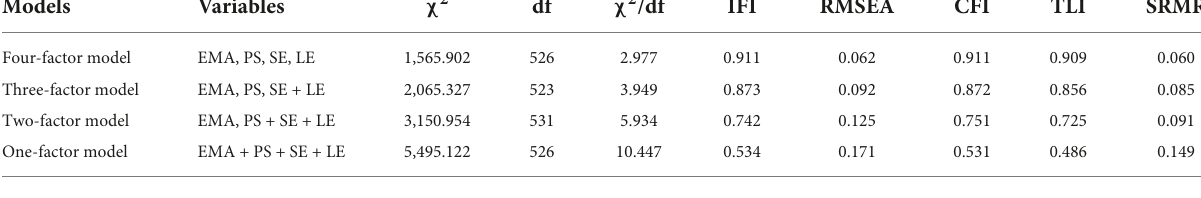
TABLE 2 Results of correlation